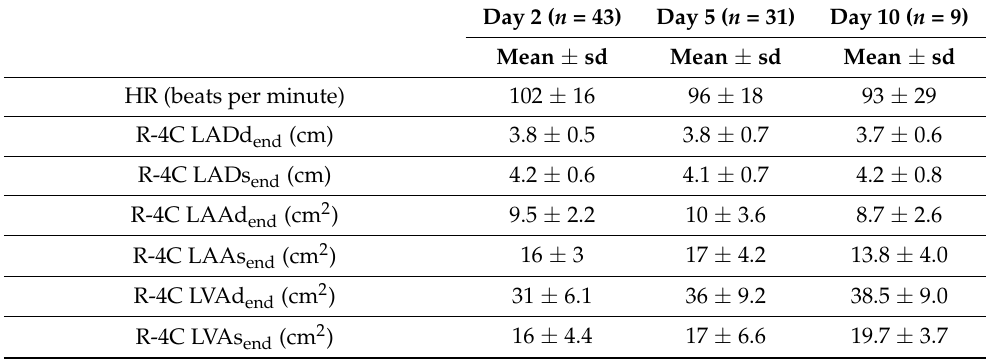
Table 3. Echocardiographic measurements in 48 healthy and diseased foals at 2, 5 and 10 days of